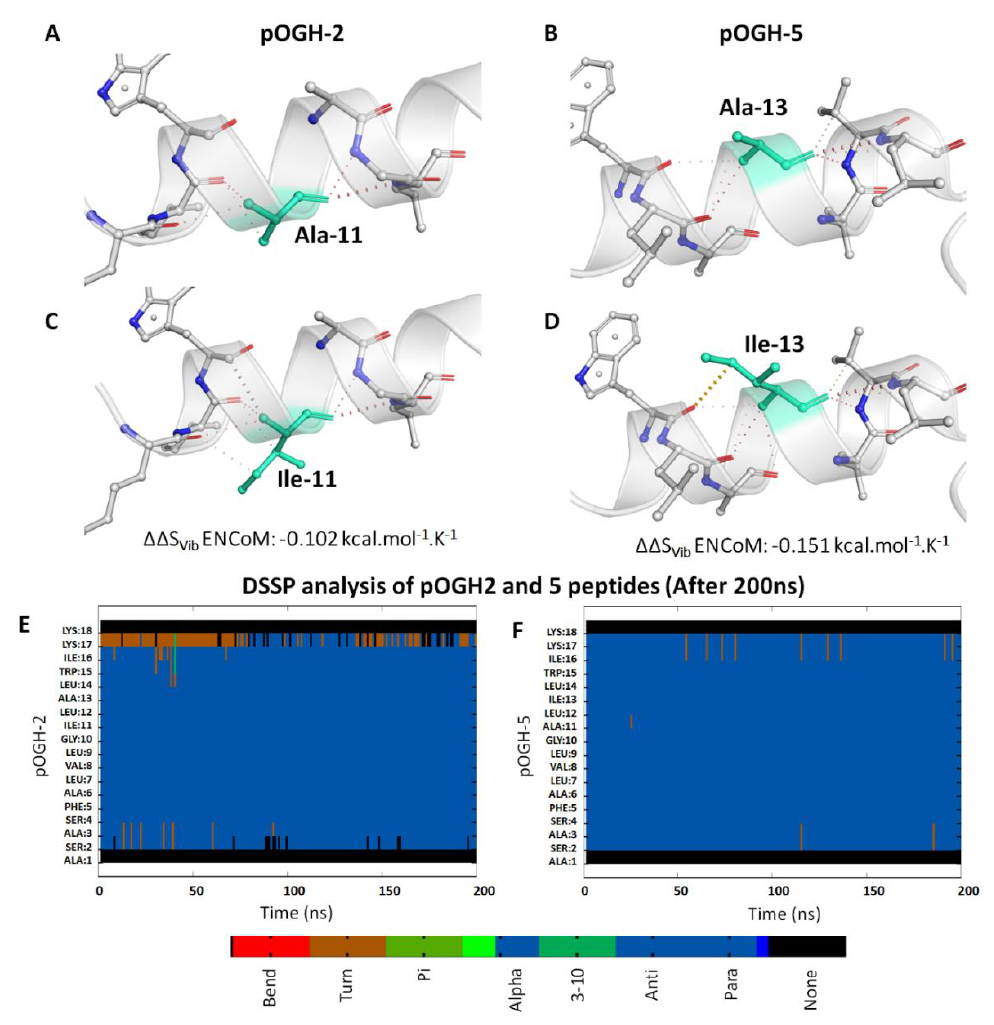
Figure 5. Representation of electrostatic and van der Waals interactions of native ( A ) and ( B ), and mutants ( C ) and ( D ) after replacement of isoleucine at positions − 11 (pOGH-2) and − 13 (pOGH-5). DSSP analysis for the secondary structure fluctuations throughout 200 ns for pOGH-2 ( E ) and pOGH-5 ( F ).